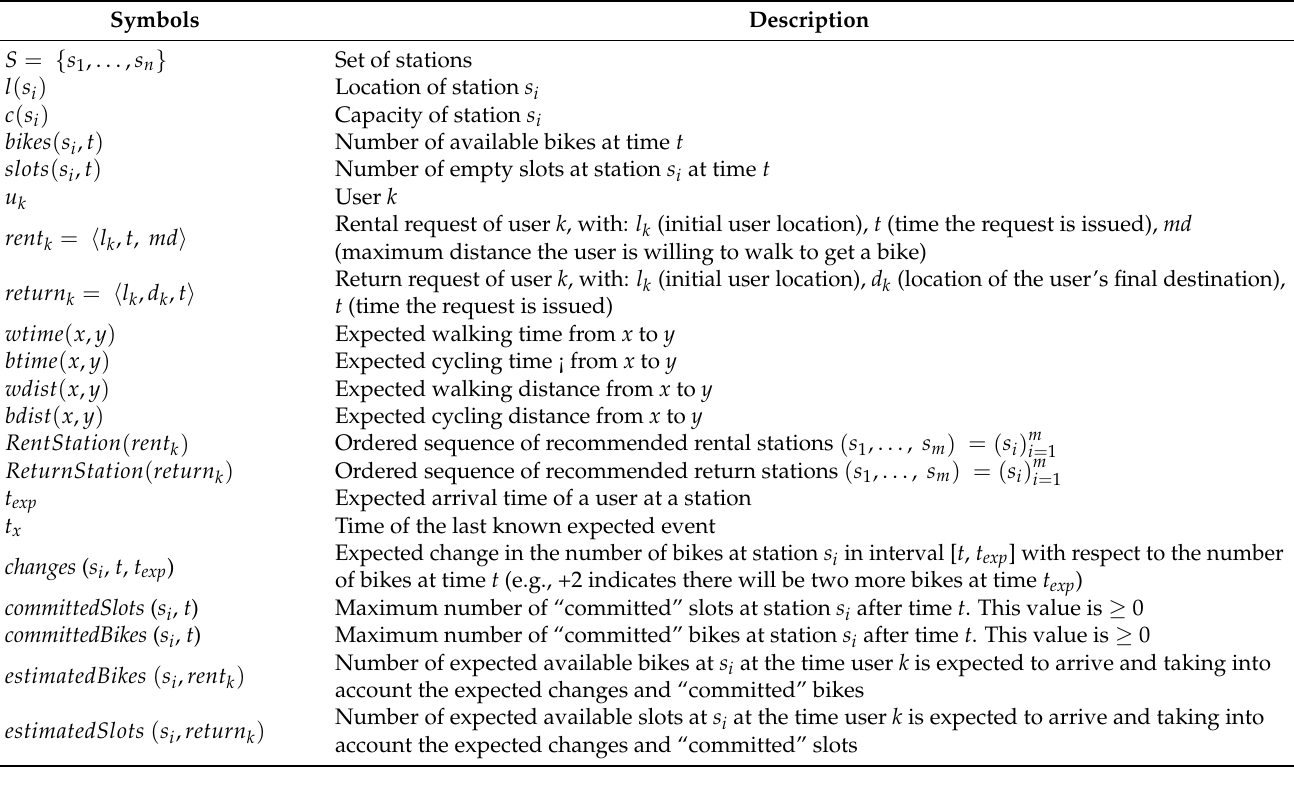
Table 1. List of symbols and functions